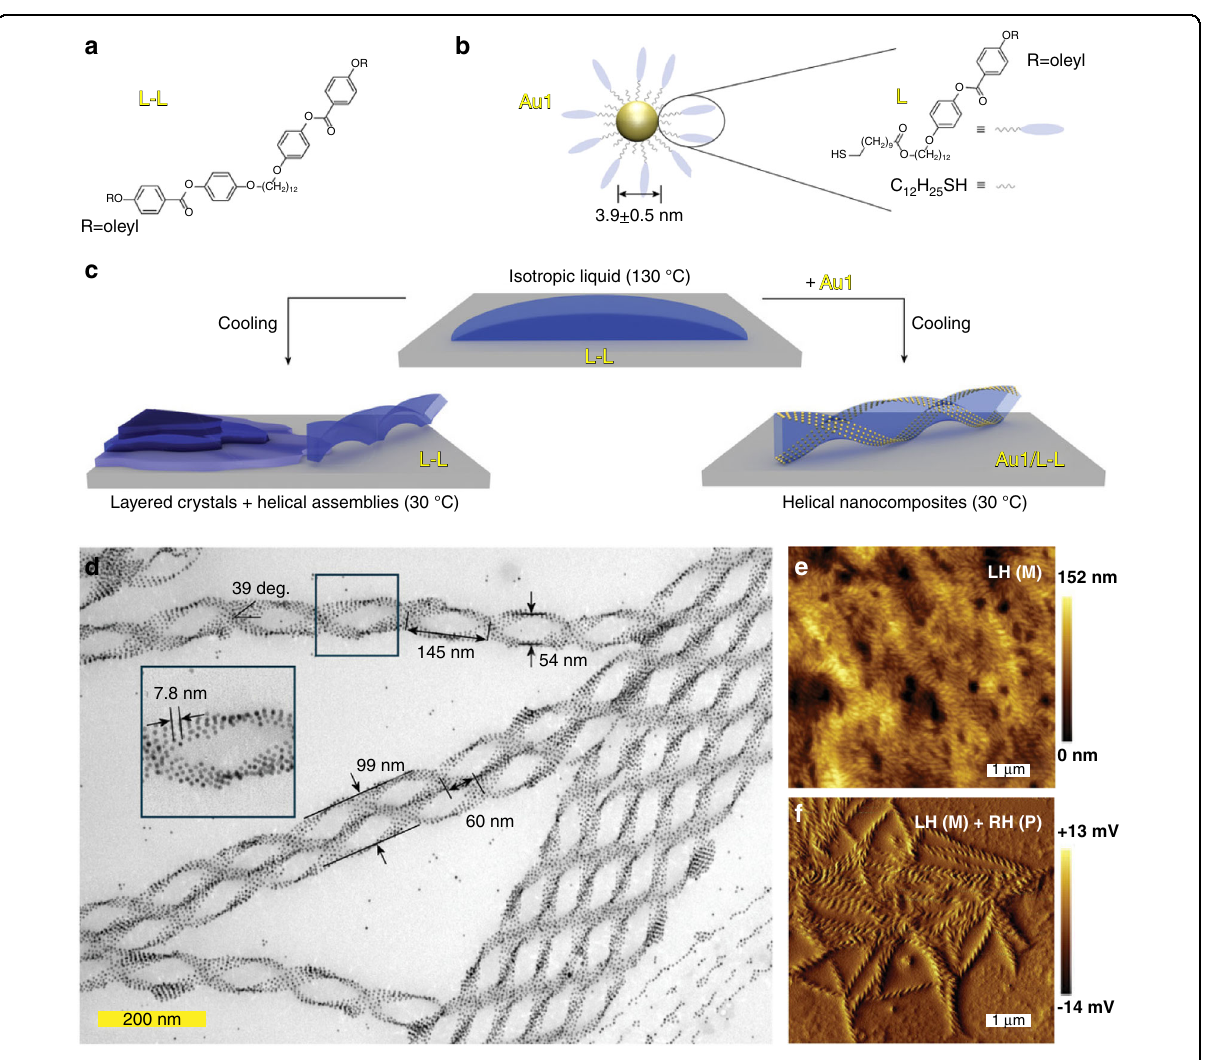
Fig. 4 Self-assembly of mesogen-functionalized gold nanoparticles into left- and right-handed chiral nanomaterials with thermotropic liquid-crystalline template. a Molecular structure of a mesogenic dimer (L – L). b Schematic structure of the mesogen-functionalized gold nanoparticle. c Schematic self-assembly process of chiral plasmonic nanomaterials. d TEM image of chiral nanomaterials. e , f AFM images of left- and right-handed chiral nanomaterials. Reproduced with permission from ref. 188 . Copyright 2020,